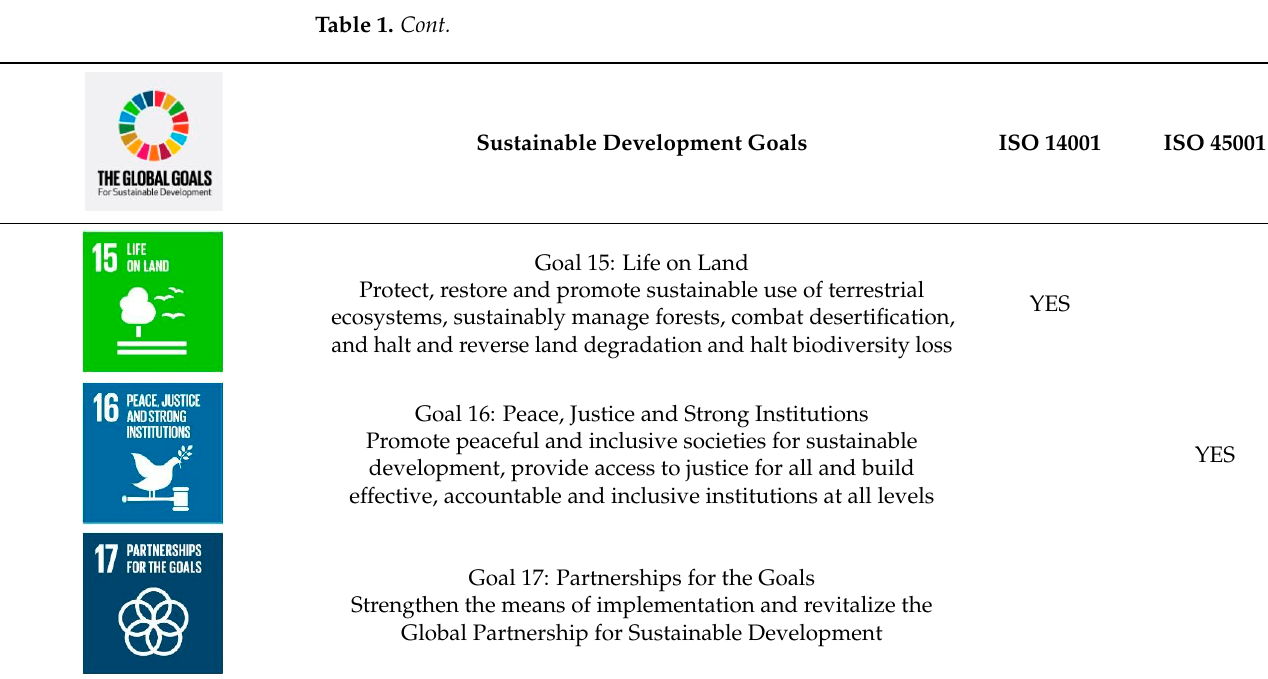
Table 1. ISO 14001 and 45001 contribute to the following Sustainable Development Goals (Adapted Table 1. Cont. with permission from [20] by the